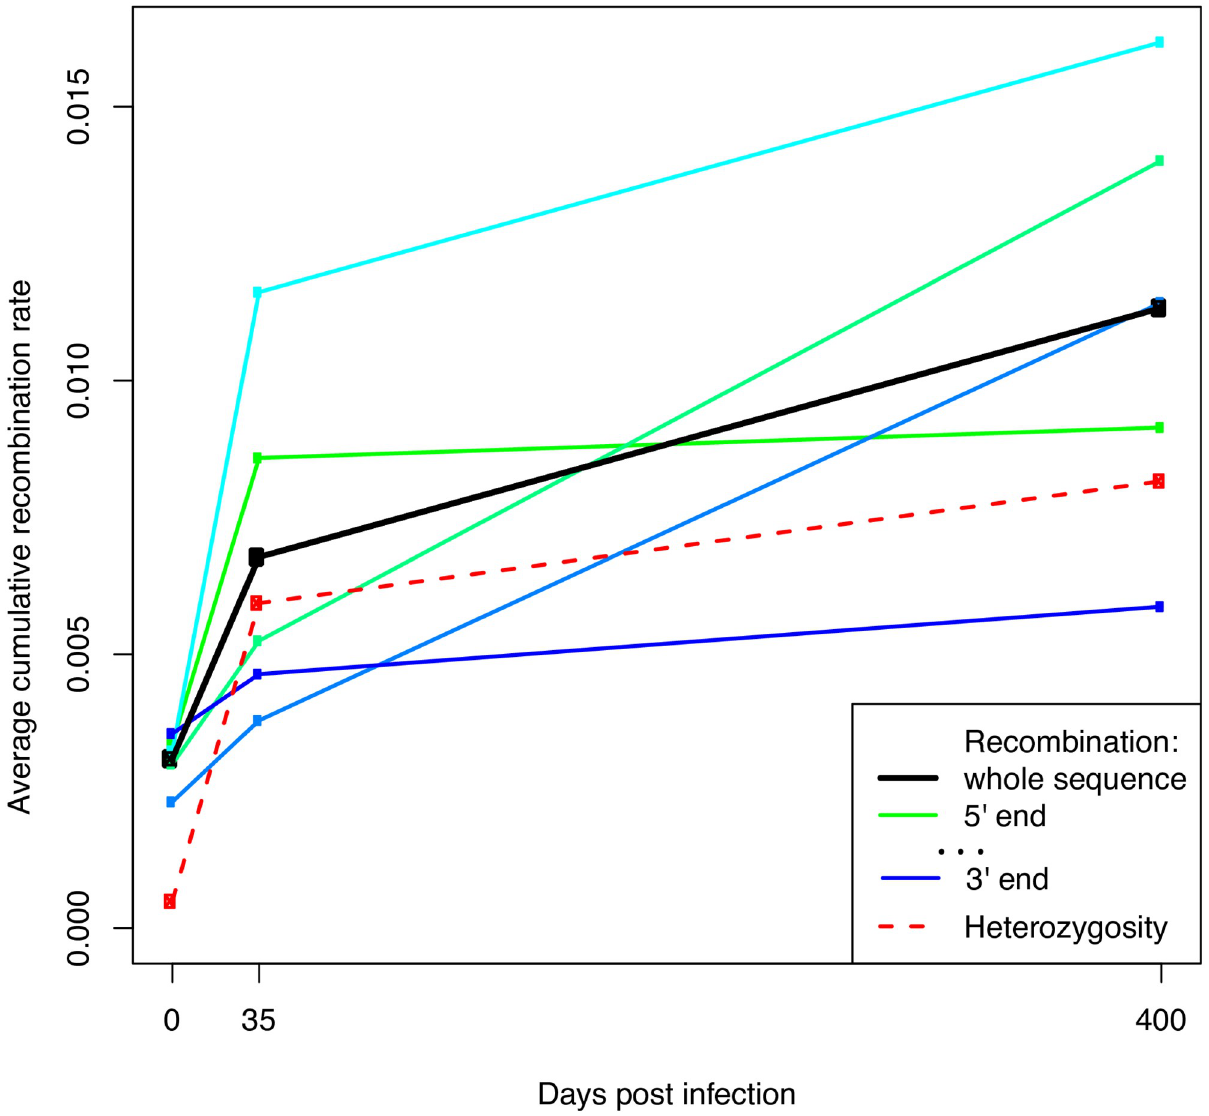
Fig 4. Cumulative recombination rates in VP1-coding sequences from the inoculum and from animals sampled at 35 and 400 dpi. All the rates are defined from the beginning of the experiment to the sampling time of the sequences and are computed using the “local” approach. Recombination rates for the 1st, 2nd, 3rd, 4th and 5th fifth of the the VP1-coding sequence are shown with a green-blue gradient from the 5’ to the 3’ end. The dashed red line shows the heterozygosity per base, computed on the intra-swarm SNVs (i.e. variants unrelated to the main sub-population structure).